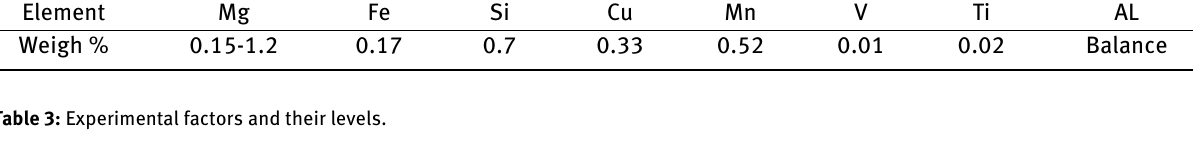
Table 2: Chemical composition of AL-6061 alloy [5]. Element